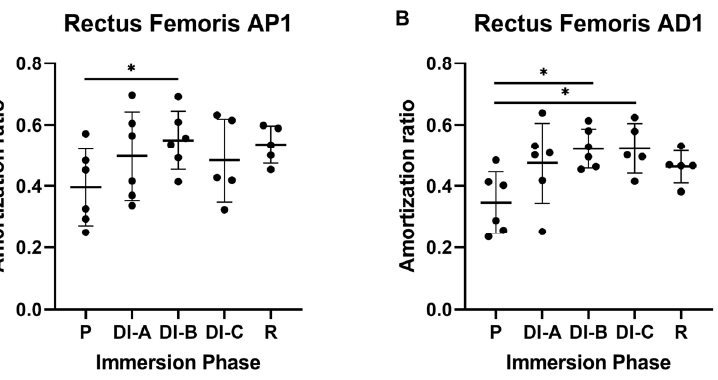
Figure 5. Amortization ratio for rectus femoris muscle (RF): ( A ) close proximal propagation (P1) and ( B ) close distal propagation (D1). The statistical significance of results is noted with an asterisk (*): * p < 0.05.